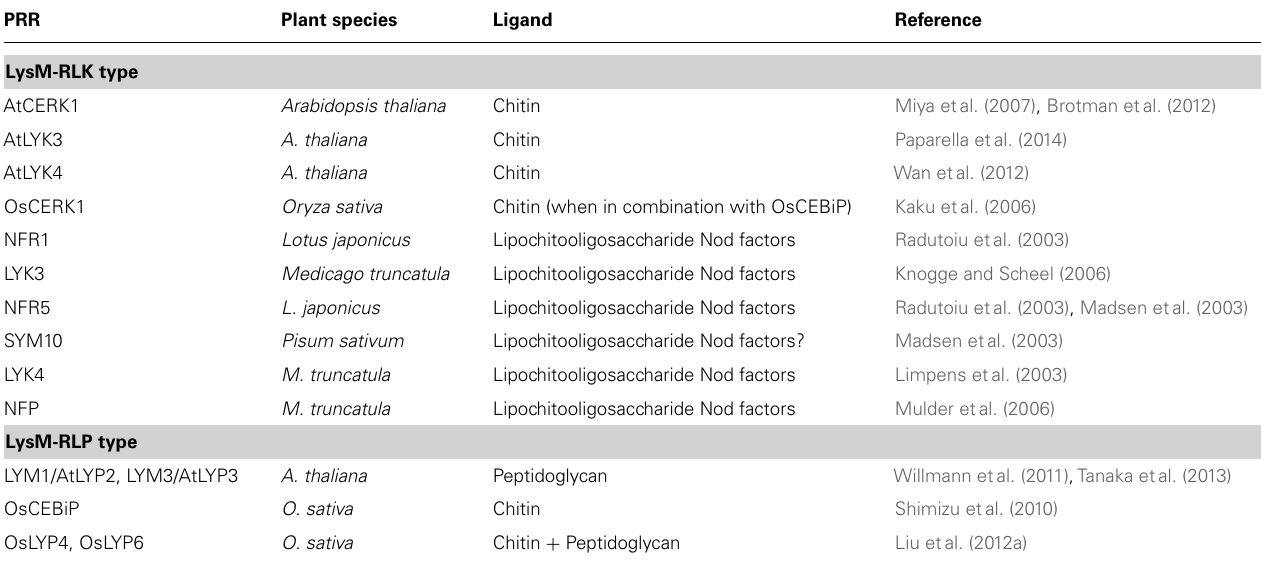
Table 2 | Membrane-bound lectin-type PRRs involved in plant defense signaling and symbiosis.